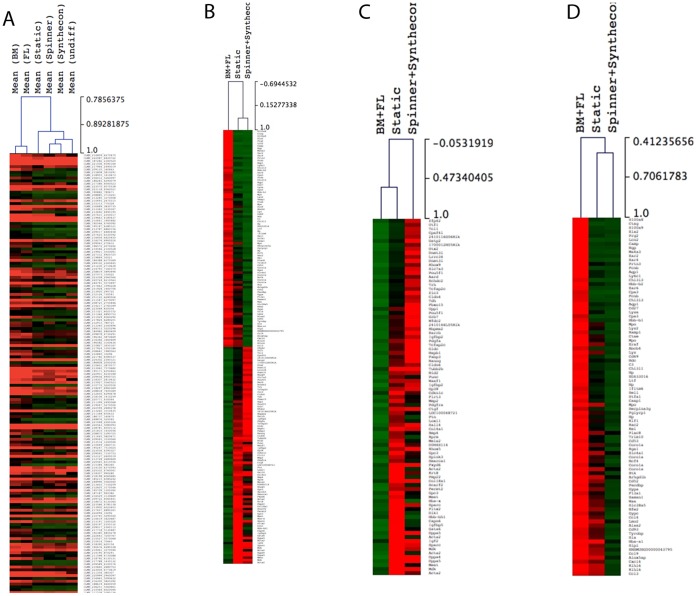
Global gene expression profile of BM- and FL-isolated as well as in vitro generated Lin-ckit+Sca-1+ progenitor cells.
A) Sample Hierarchical clustering represents the conditions that cluster together based on differentially expressed genes (DEG) across all samples (mean of gene expression values for each group, One way Anova, p<0.05). B) Gene Hierarchical clustering of 5-fold DEG across native (BM+FL),Static and Dynamic (Spinner+Synthecon) culture conditions. Gene Hierarchical clustering of 5-fold DEG up-regulated (C) or down-regulated (D) in Static and Dynamic (Spinner and Synthecon) in vitro culture conditions compared to native isolated LKS cells (BM+FL). The genes used in these heat maps are listed within Supplementary material.